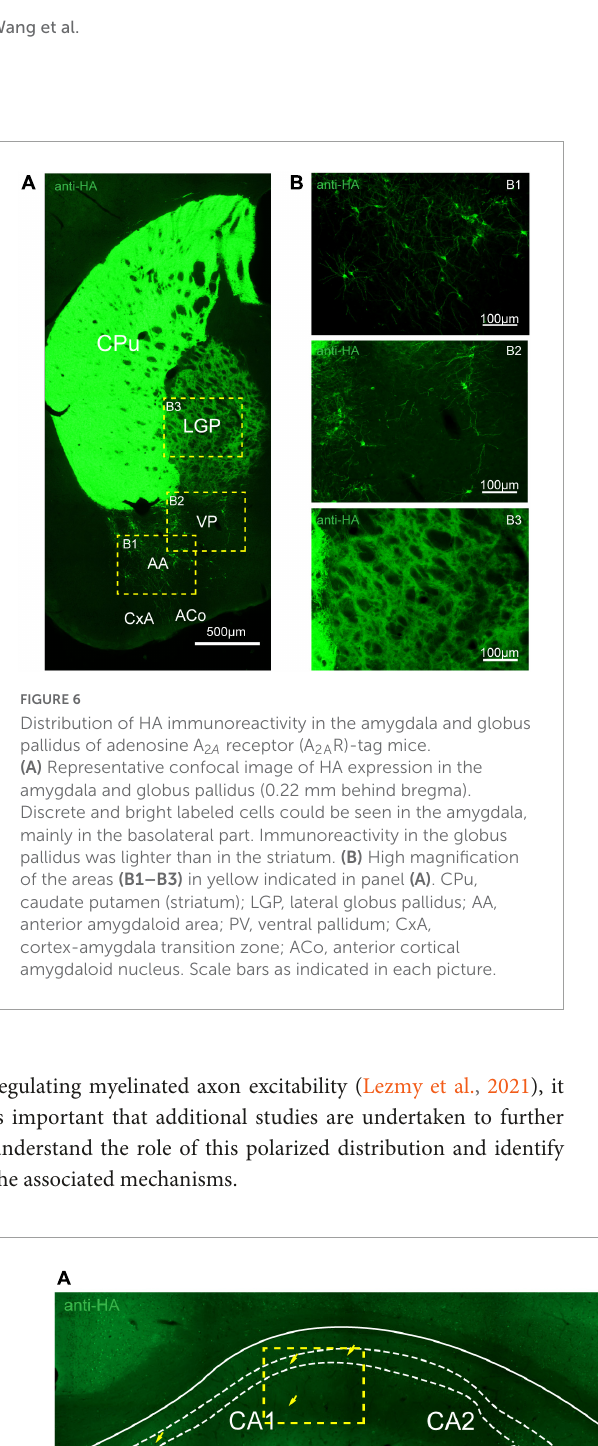
FIGURE7 Distribution of HA immunoreactivity in the hippocampus of adenosine A 2 A receptor (A 2A R)-tag mice. (A) Representative confocal image of HA expression in the hippocampus (1.82 mm behind bregma). Very lightly labeled cells (arrows) with evident pyramidal morphology could be seen in the CA1 and CA2 regions, but not in the dentate gyrus. (B) High magnification of the area in yellow indicated in panel (A) . CA1, field CA1 of the hippocampus; CA2, field CA2 of hippocampus; CA3, field CA3 of the hippocampus; DG, dentate gyrus. Scale bars as indicated in each